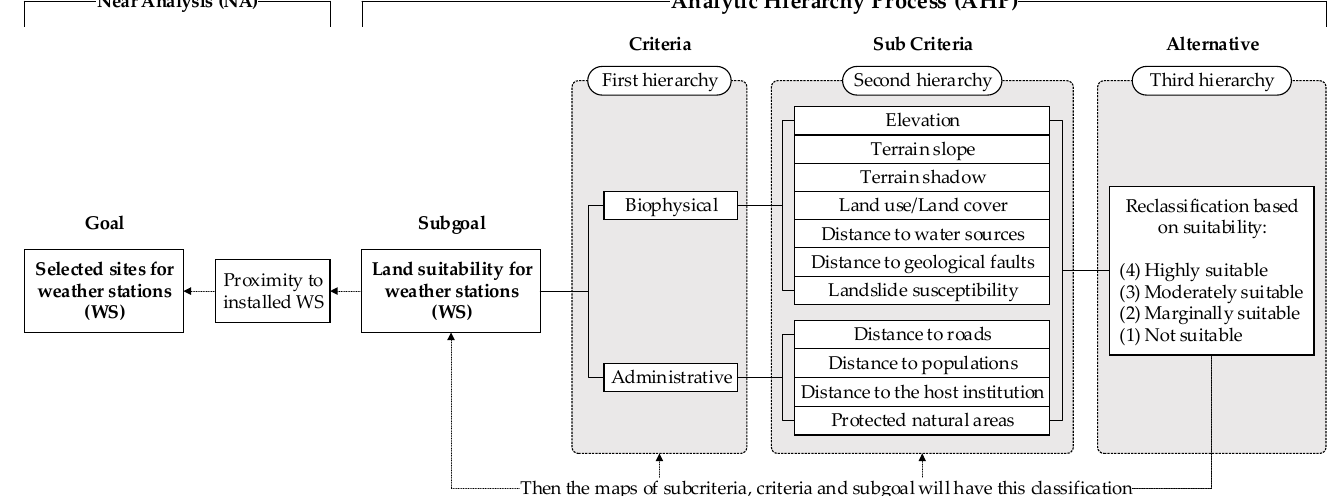
Figure 2. Methodological process with hierarchy of objectives and criteria for the selection of sites for meteorological stations in Amazonas, NW Peru.